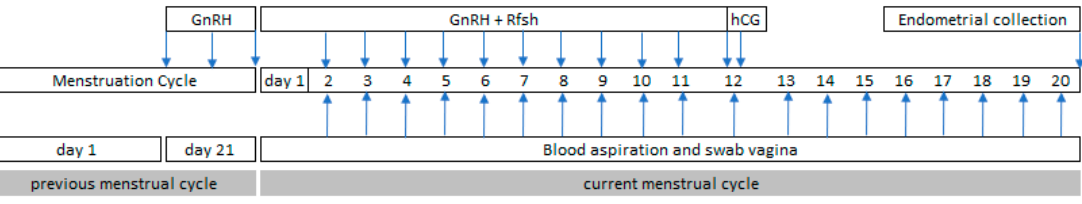
Figure 1. Controlled ovarium hyperstimulation (COH) procedure.